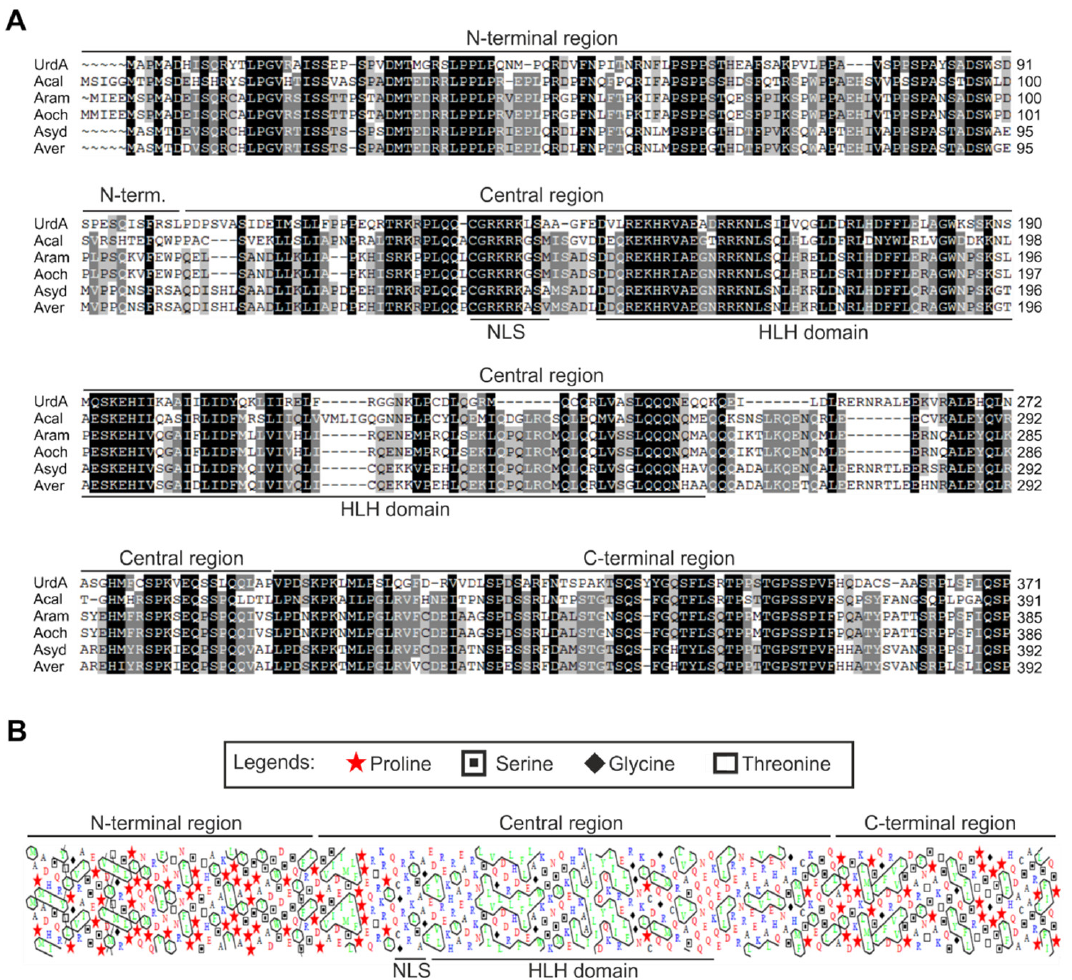
Figure 1. Multiple Sequence Alignment of UrdA orthologs from Aspergillus species. Sequences from orthologs of ( A ) A. nidulans (UrdA), A. Calidoustus (Acal), A. rambellii (Aram), A. ochraceoroseus (Aoch), A. sydowii (Asyd) and A. versicolor (Aver) were aligned using Clustal Omega and visualized using Genedoc (see Materials and Methods). The extension of the predicted N-terminal, central and C-terminal regions, as well as the putative nuclear localization signal (NLS) and helix-loop-helix (HLH) domains are indicated by black lines. ( B ) Hydrophobic cluster analysis (HCA) of UrdA. Residues in green indicate hydrophobic clusters and, thus, possible secondary structures. Residues in blue are positively charged amino acids while those in red are negatively charged. Proline, serine, glycine and threonine are designated by symbols. See Materials and Methods for additional details.